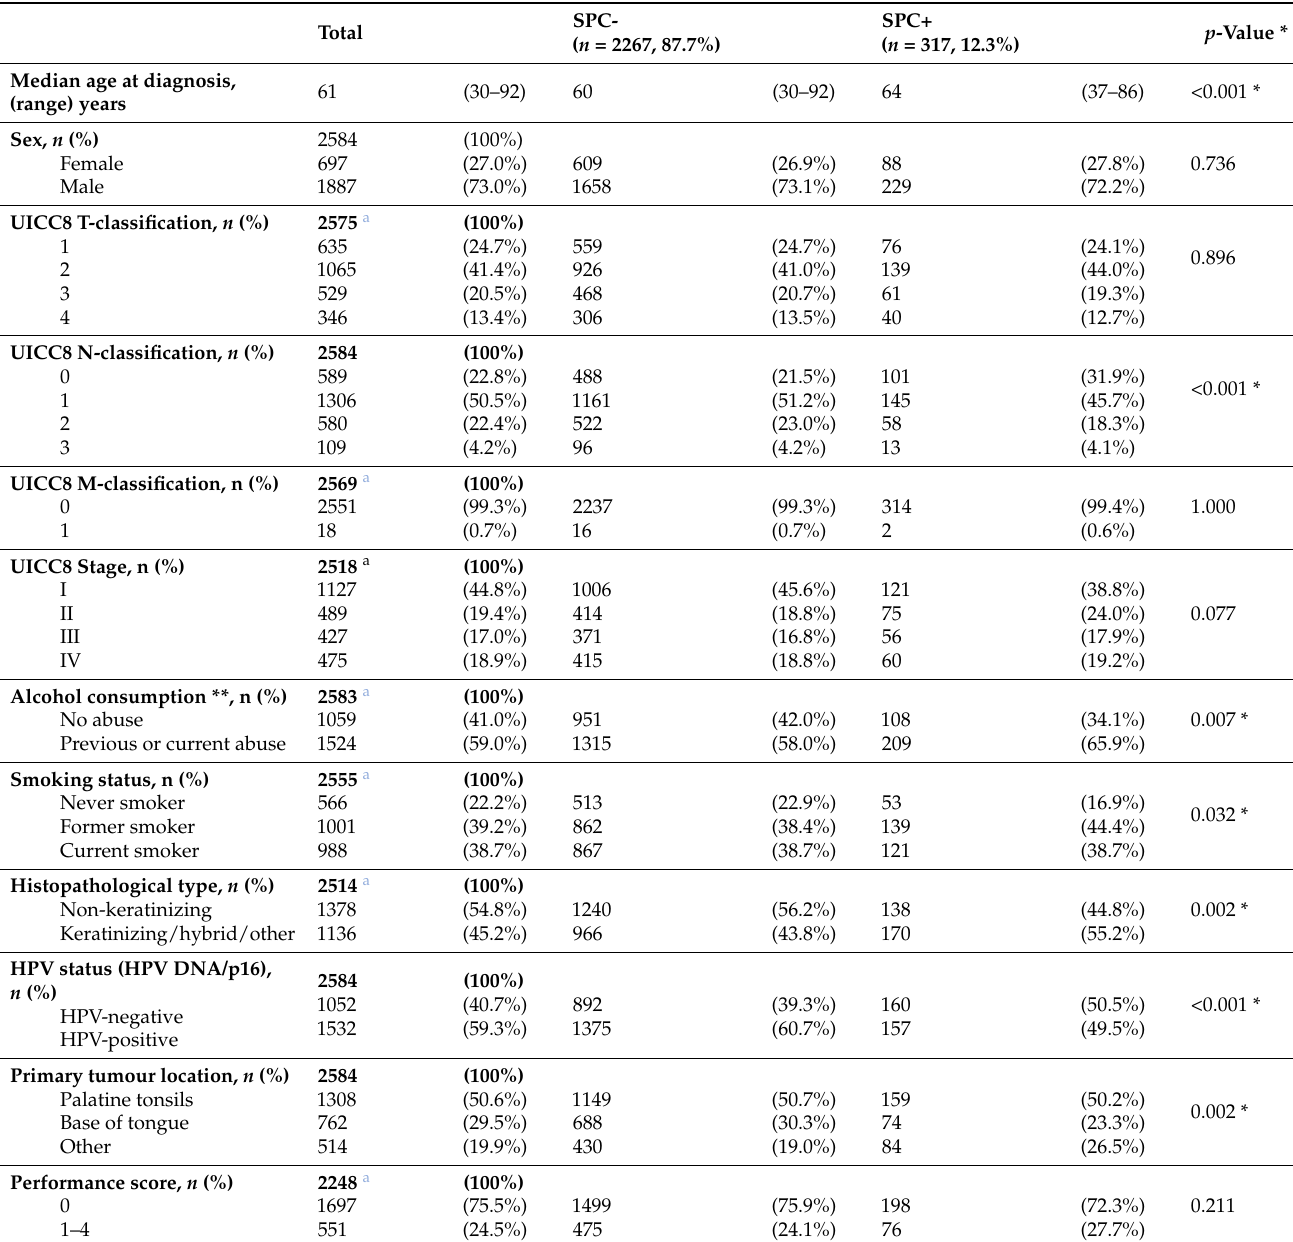
Table 1. Baseline characteristics of patients with and without second primary cancer (SPC) following primary oropharyngeal squamous cell carcinoma (OPSCC) diagnosed in eastern Denmark during